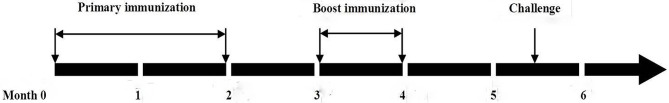
Design of oral immunization assay of zebrafish.